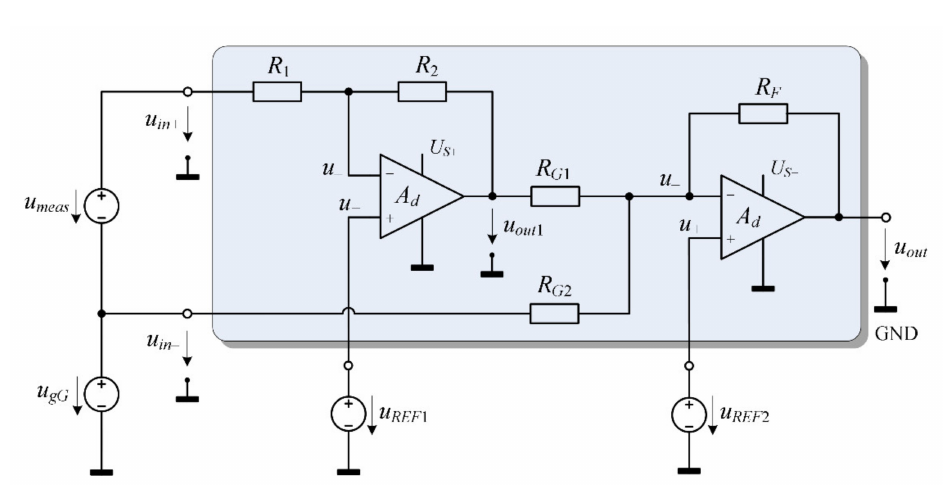
Figure 5. A schematic of a two-stage difference